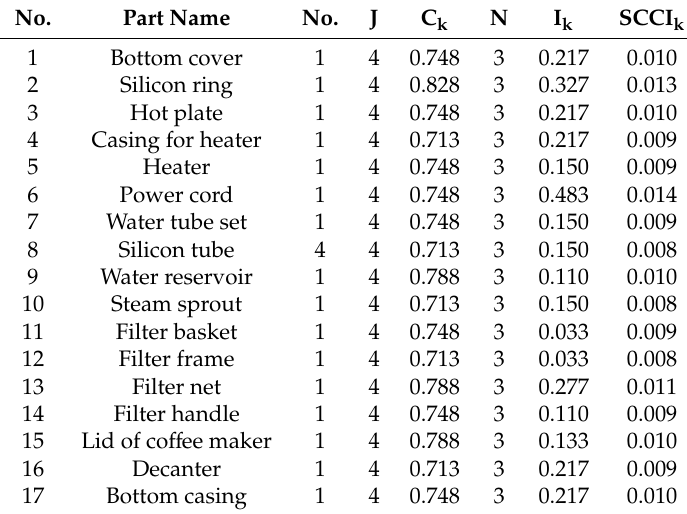
Table 4. Complexity information of the co ff ee